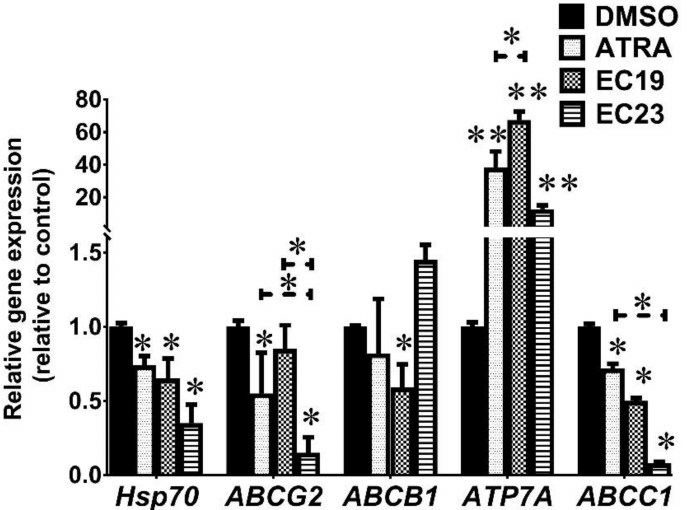
Figure 5. Gene expression analysis using RT-qPCR of retinoid-treated Caco-2 cells. The cells were treated with the IC 50 concentrations of retinoids for 24 h and the qPCR reactions were carried out using HERA PLUS SYBR ® Green qPCR Kit. The differential gene expression of the indicated genes was performed using the 2 − ∆∆ CT method in comparison to the negative control (0.1%DMSO). Shown is the mean ± SEM of three independent experiments ( n = 3). * p < 0.05 and ** p < 0.01 indicate statistically significant difference compared to negative control.